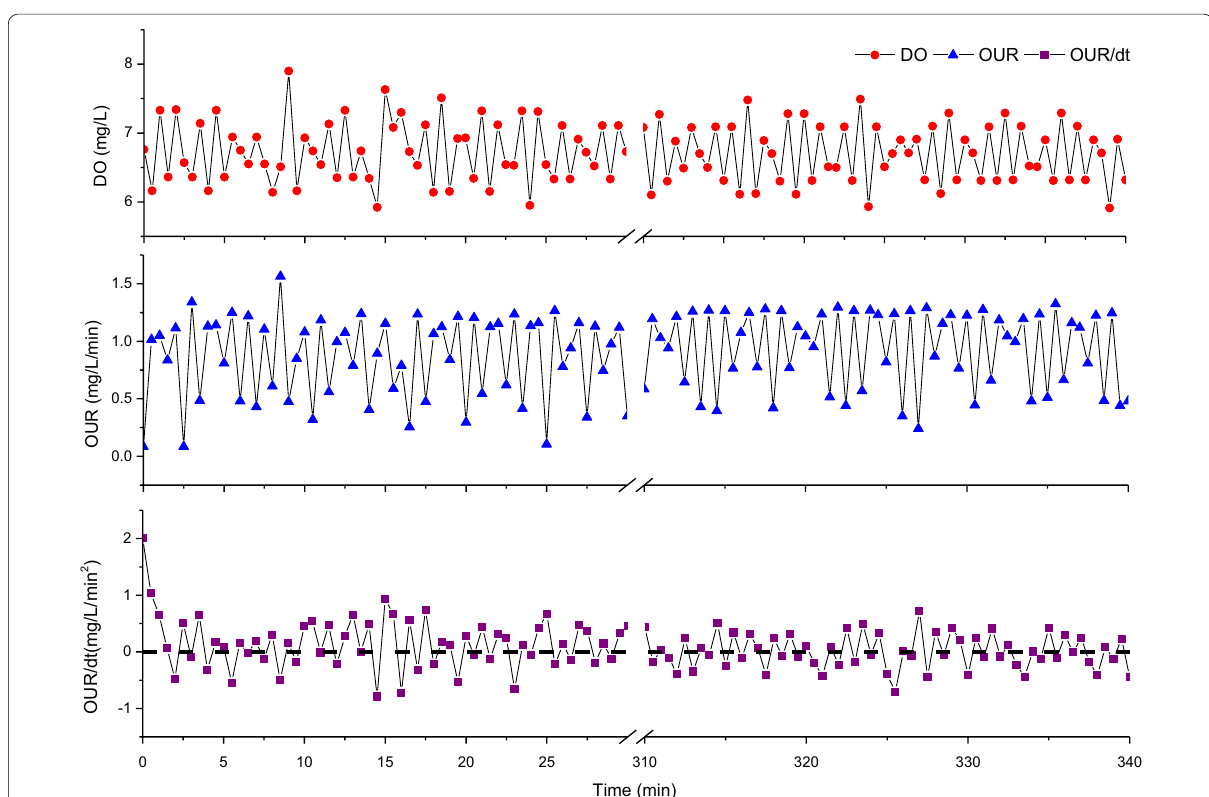
Fig. 3 The signal of DO (red cycle), OUR (blue triangle) and dOUR/dt (purple square) during the feast phase in a typical cycle applying the feed-on-demand control